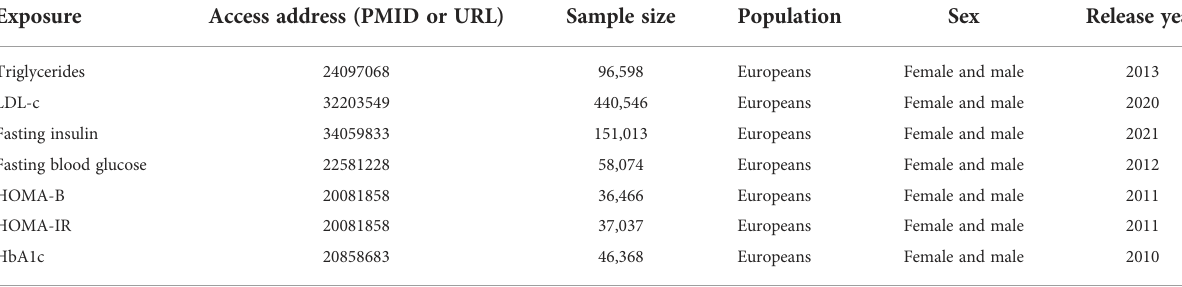
TABLE 1 Description of genome-wide association study used for each confounder.